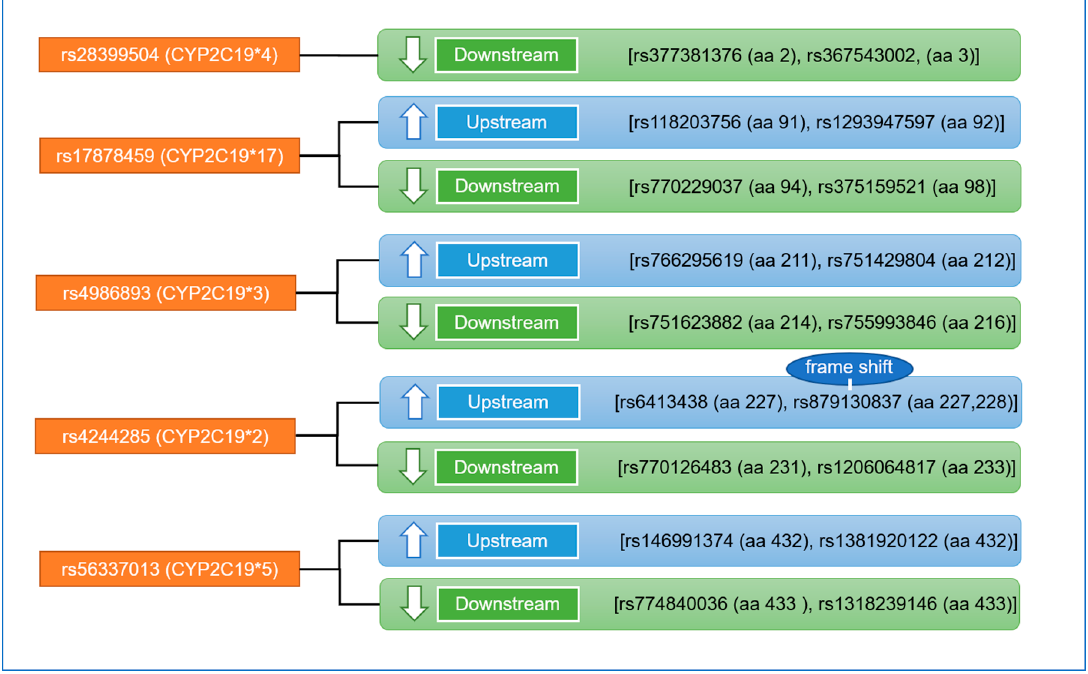
Figure 6. Five single nucleotide polymorphisms (SNPs) of the CYP2C19 gene that are involved in drug metabolism. We identified two upstream and two downstream for each of those SNPs and their location in the gene sequence.